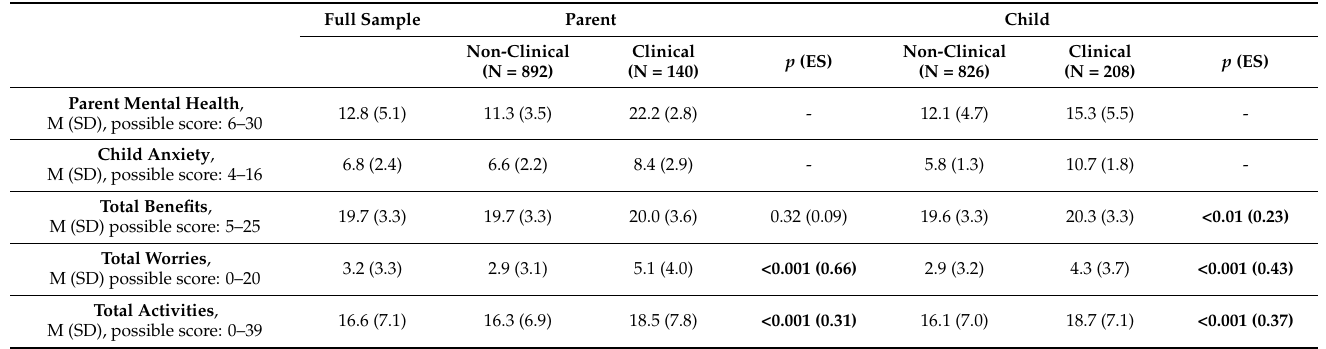
Table 3. Summary descriptives for perceived benefits, worries and pet-related activities for overall sample and for parents and children with poor mental health (N =